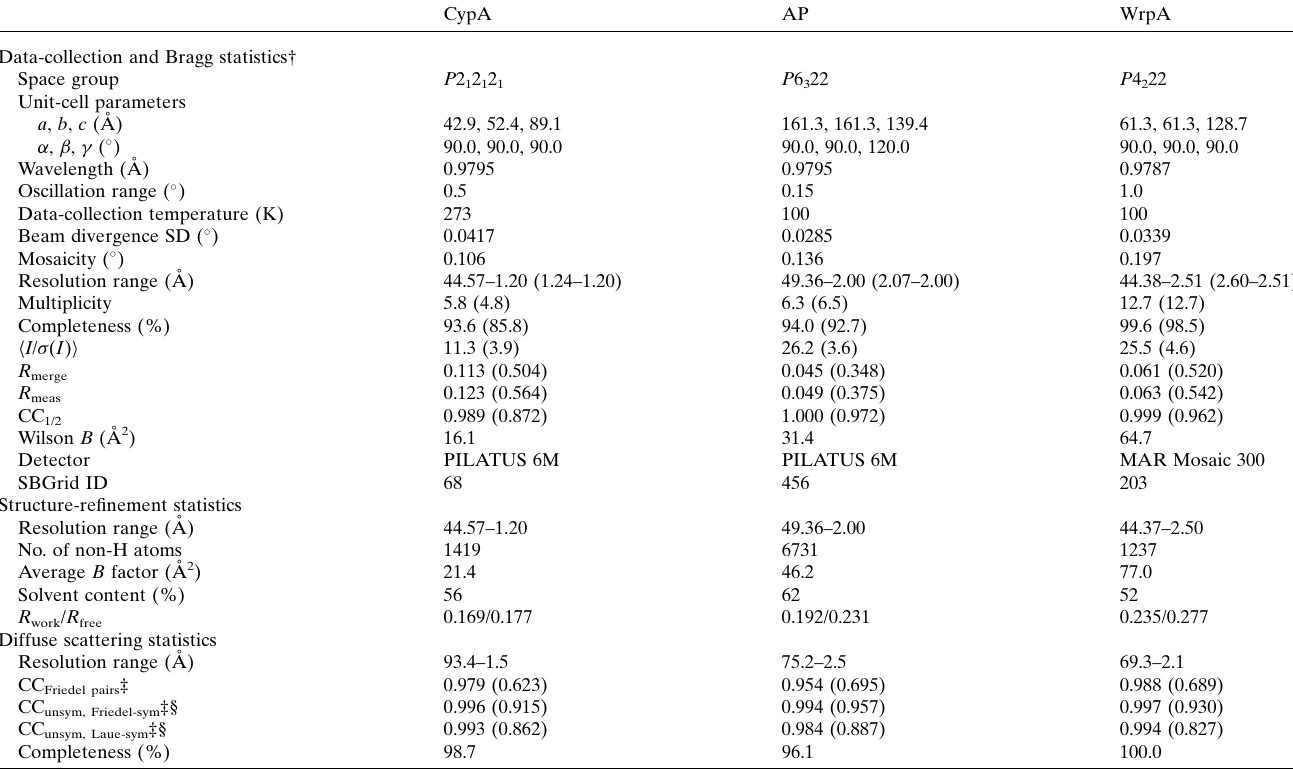
Table 1 Data collection, model and map